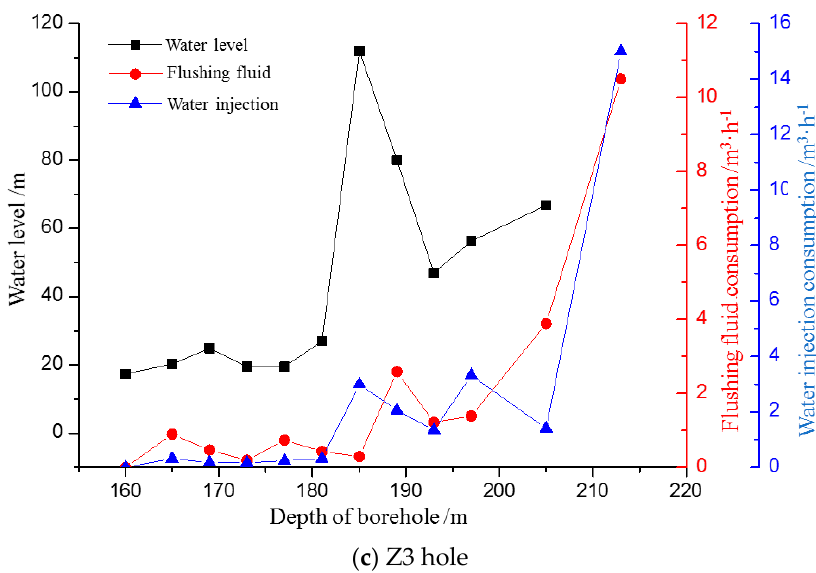
Figure 9. Variations in water levels, flushing fluid consumption, and water injection at Z1, Z2, and